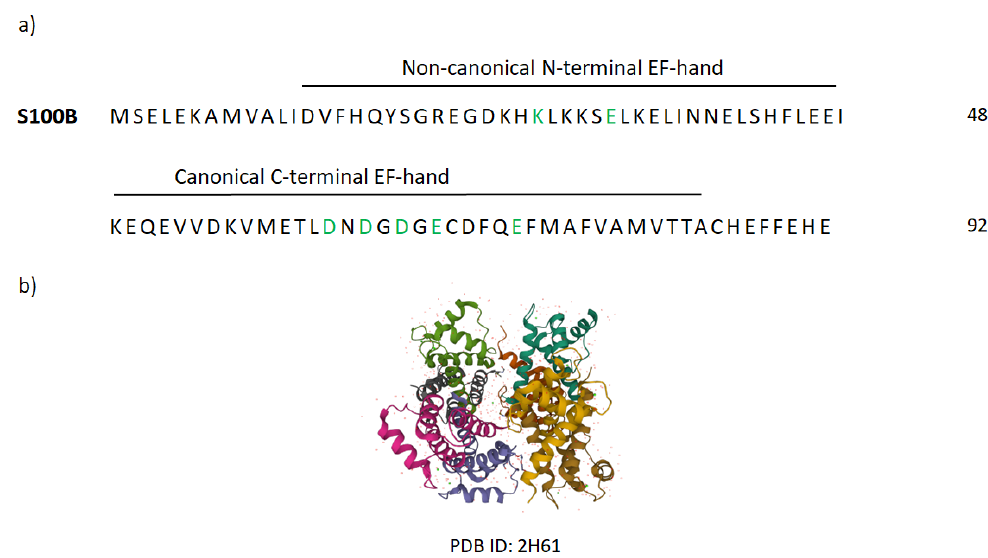
Figure A6. Structures of S100B protein: ( a ) predicted amino acid sequence of the human S100B (the green color marks the amino acids that bind Ca 2+ ); ( b ) structure of human Ca 2+ -loaded S100B—image from the RCSB PDB (rcsb.org) of PDB ID 2H61 [276].